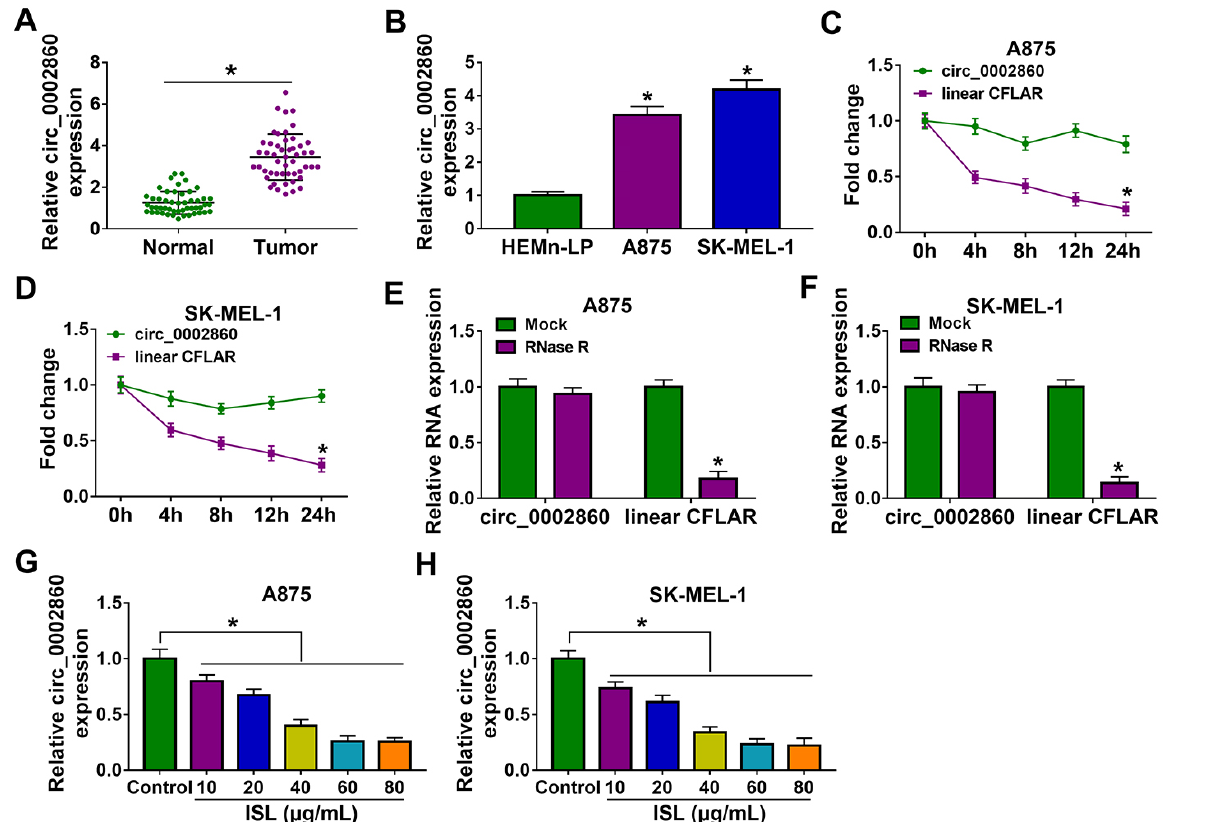
Figure 1. ISL downregulated the level of circ_0002860 in melanoma cells. RT-qPCR was used for circ_0002860 level detection in melanoma (A) tissues and (B) cells. (C, D) Circ_0002860 and CFLAR levels were determined after A875 and SK-MEL-1 cells were incubated with actinomycin D for 0 h, 4 h, 8 h, 12 h and 24 h. (E, F) The quantification of circ_0002860 and CFLAR was performed by RT-qPCR after total RNA was treated with RNase R for 1 h. (G, H) The circ_0002860 expression was assayed using RT-qPCR after treatment of ISL (10 µg/mL, 20 µg/mL, 40 µg/mL, 60 µg/mL, 80 µg/mL) in A875 and SK-MEL-1 cells. *p <